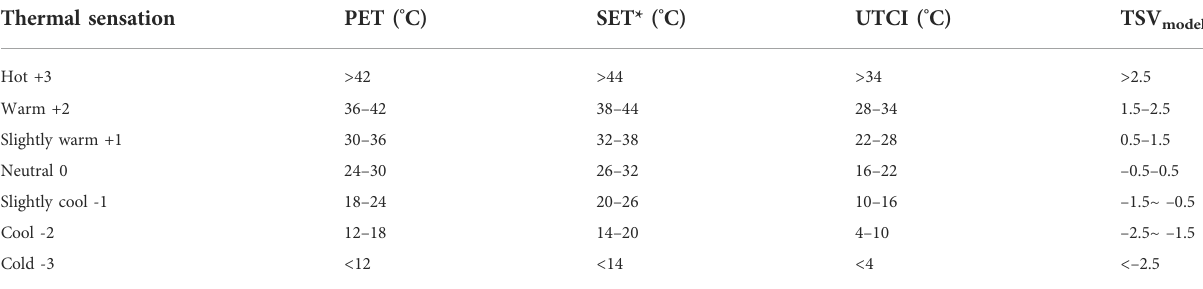
TABLE 4 Assessment scales of selected thermal indices. Thermal